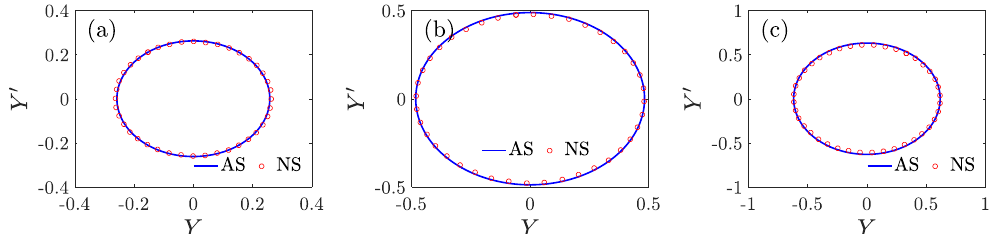
Figure 5. Comparisons between the analytical solutions and the numerical solutions; ( a ) E X = 10, E Y = 30, and σ 1 = − 30, ( b ) E X = 25, E Y = 30, and σ 1 = − 20, and ( c ) E X = 40, E Y = 30, and σ 1 = − 40. AS: analytical solutions, NS: numerical solutions.